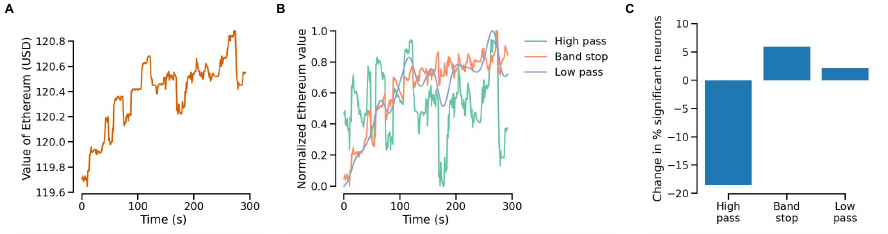
Figure 3 – Influence of different temporal components on nonsense correlations. ( A ) Example cryptocurrency price of Ethereum over a time of five hours. ( B ) The price vector from A , filtered in three different ways: High pass (0.3 cycles per hour), Band stop (0.3 - 2 cph) and Low pass (2 cph). ( C ) Filtering out the slow component of the cryptocurrency price fluctuations resulted in a large decrease in the percentage of significantly correlated neurons. Band stop and Low pass filtered traces resulted in slightly more correlated